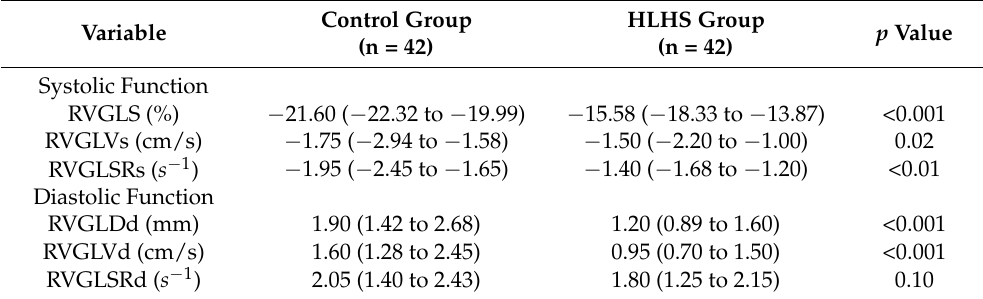
Table 3. Fetal right ventricle myocardial deformation by a two-dimensional speckle tracking echocar- diography in HLHS fetuses and normal fetuses at 23~30 gestational